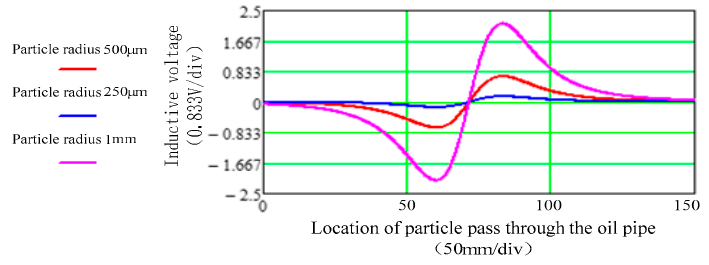
Figure 6. Induced voltage of the different size particles passing through the coils.